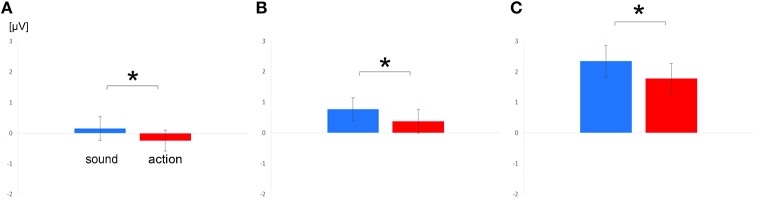
Means and standard errors of analyzed scalp regions in Experiment 2. Depicted are mean ERPs of sound and action over central scalp regions for the time window 280–380 ms (A) and 380–480 ms (B) and over parietal scalp regions for the time window 380–480 ms (C). Significant effects are highlighted by asterisks.